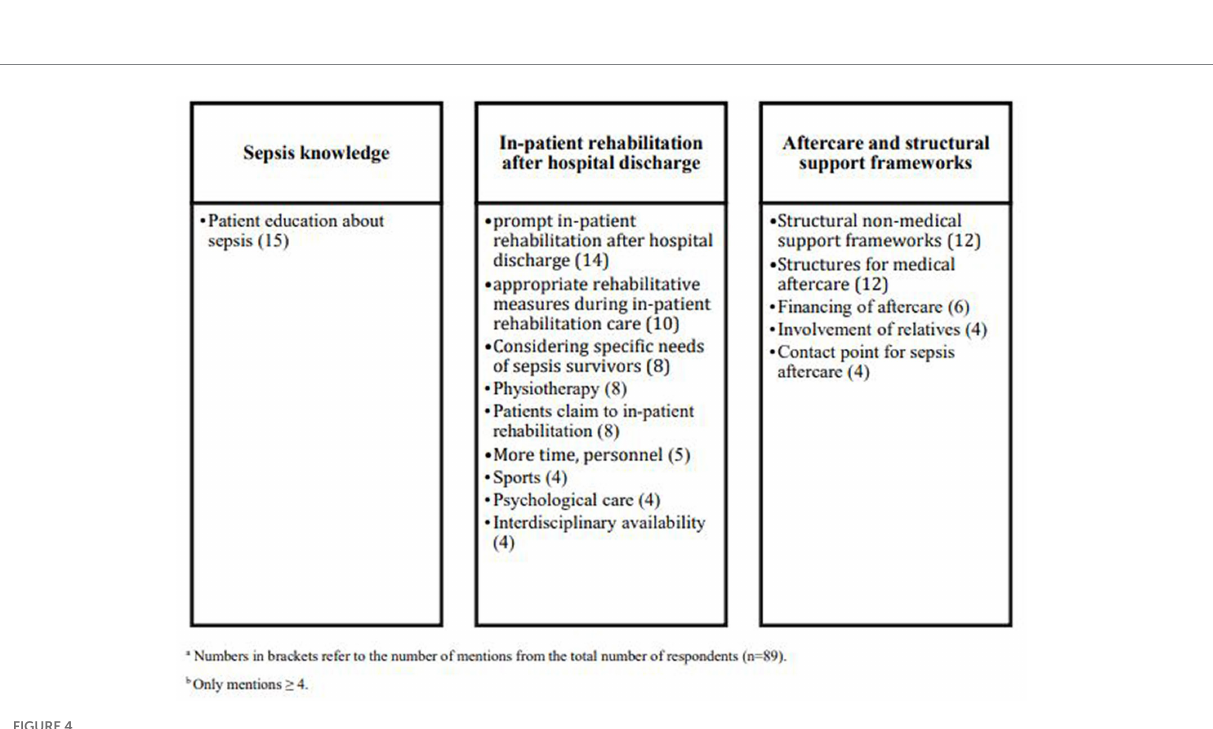
FIGURE 4 Categorized unmet needs in post–acute rehabilitation and aftercare.